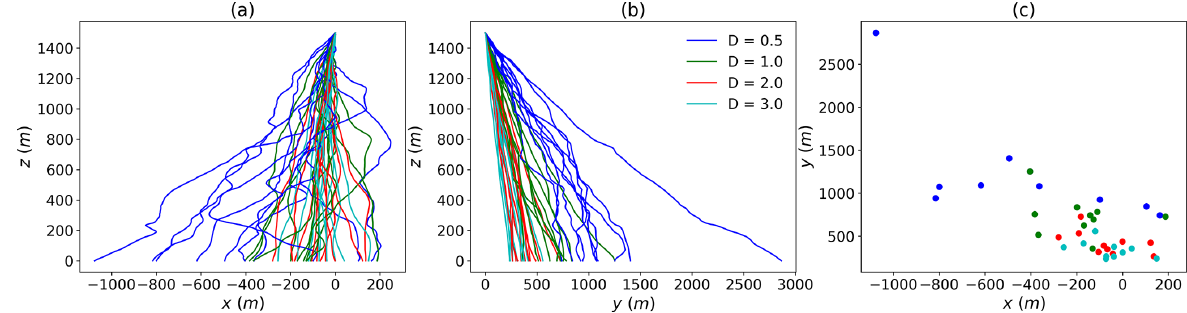
Figure 9. (a, b) Trajectories of drops of various sizes falling from the ( 0 , 0 , 1500 ) position, projected on the (x,z) and (y,z) plane, respec- tively. The low wind event is used. The ten curves correspond to different realizations of the wind shift field. (c) Position of the ground impact of the various drops.